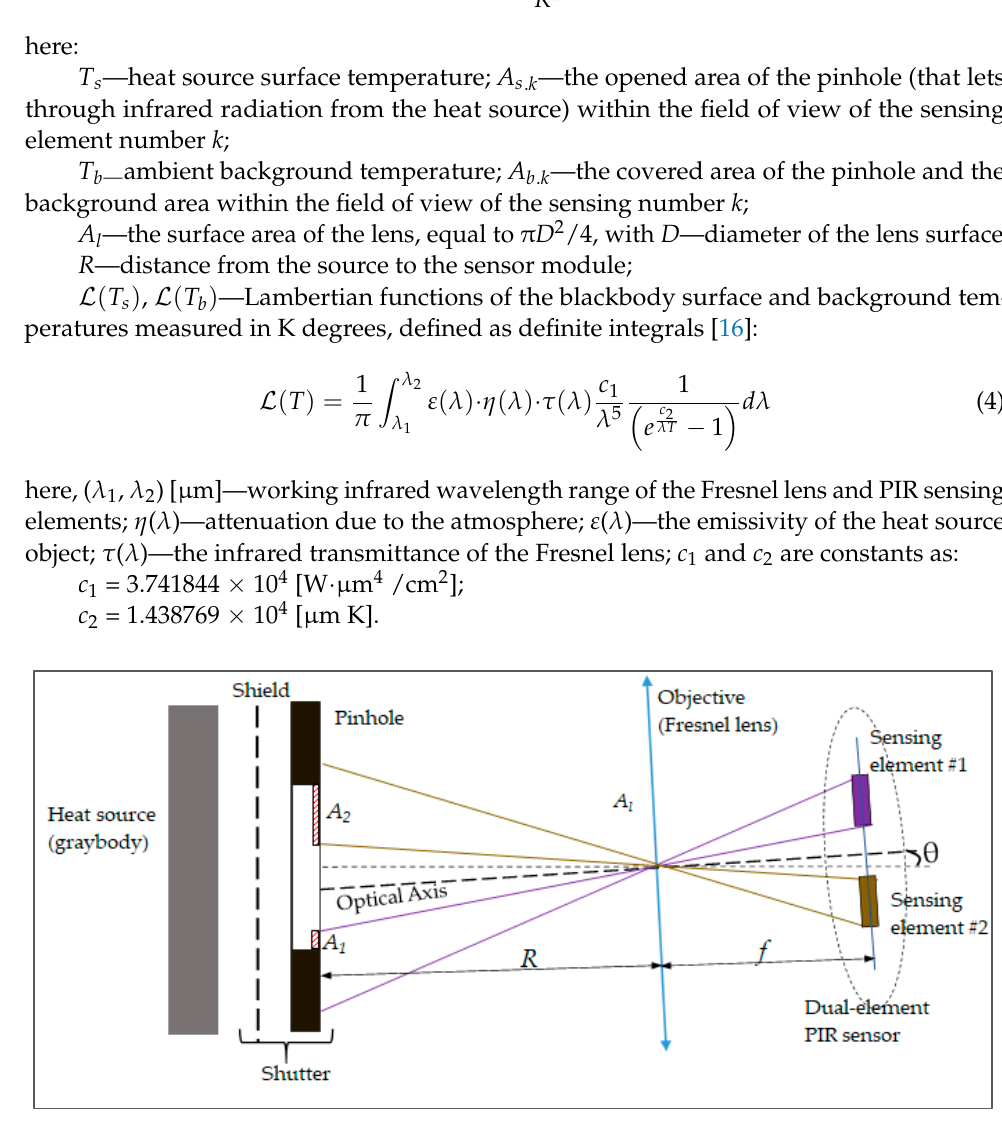
Figure 6. Determination of heat source areas within FOVs of sensing elements in the setup.